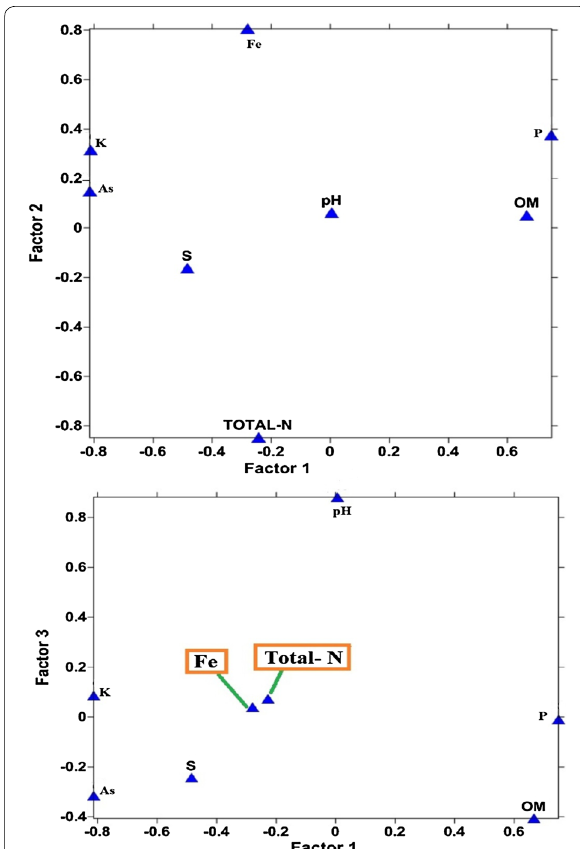
Fig. 3 The relationship between different factors for sub-surface soil samples